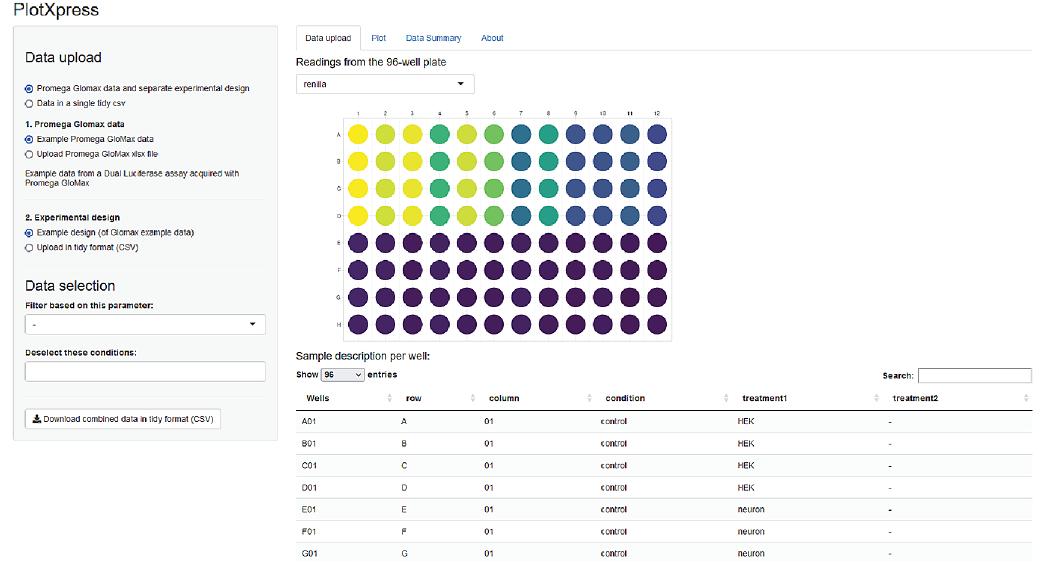
Figure 2. PlotXpress data upload. Screenshot of PlotXpress app showing a 96-well format with signal intensities represented by false